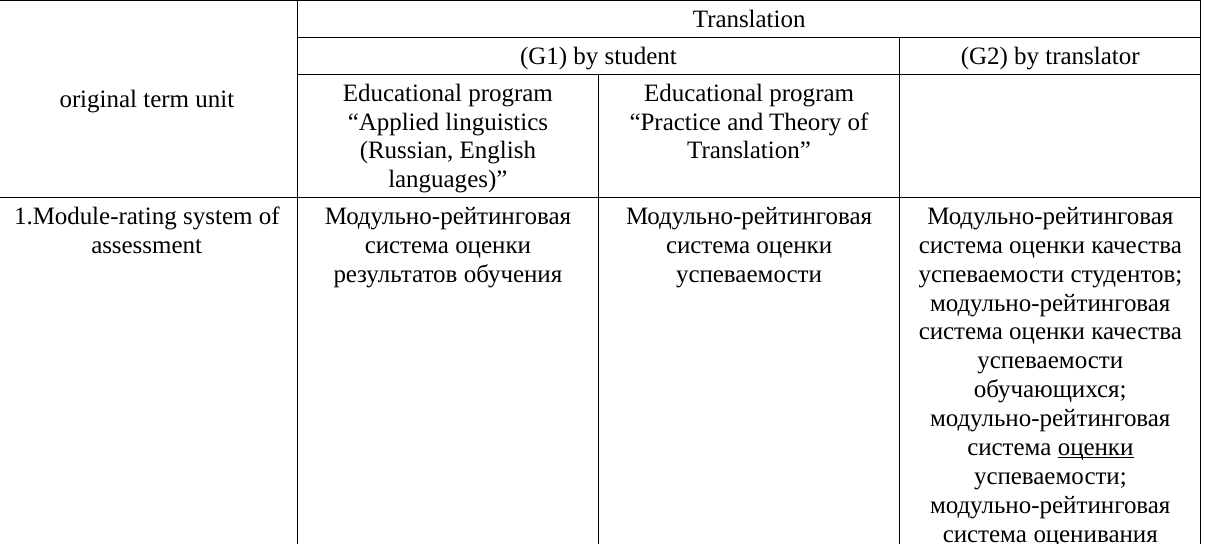
Table 1 - Recipients’ translation